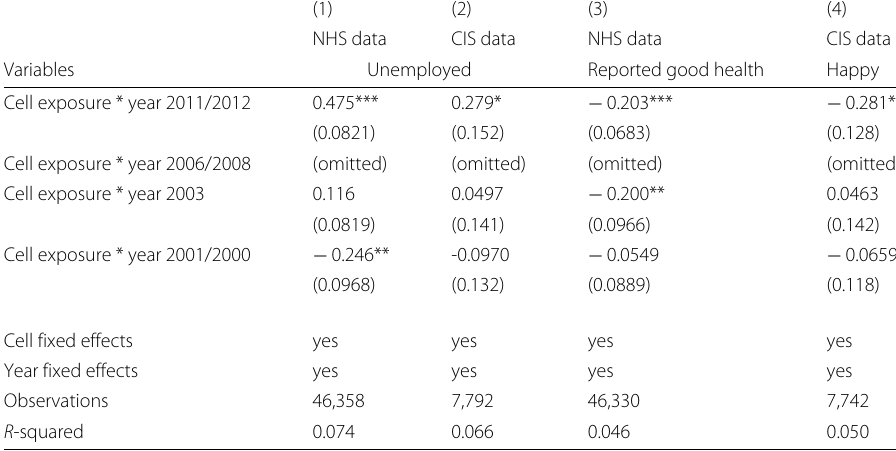
Table 10 Reduced form relationship between happiness, unemployment and exposure (1) NHS data CIS data NHS data CIS data Variables Unemployed Reported good health